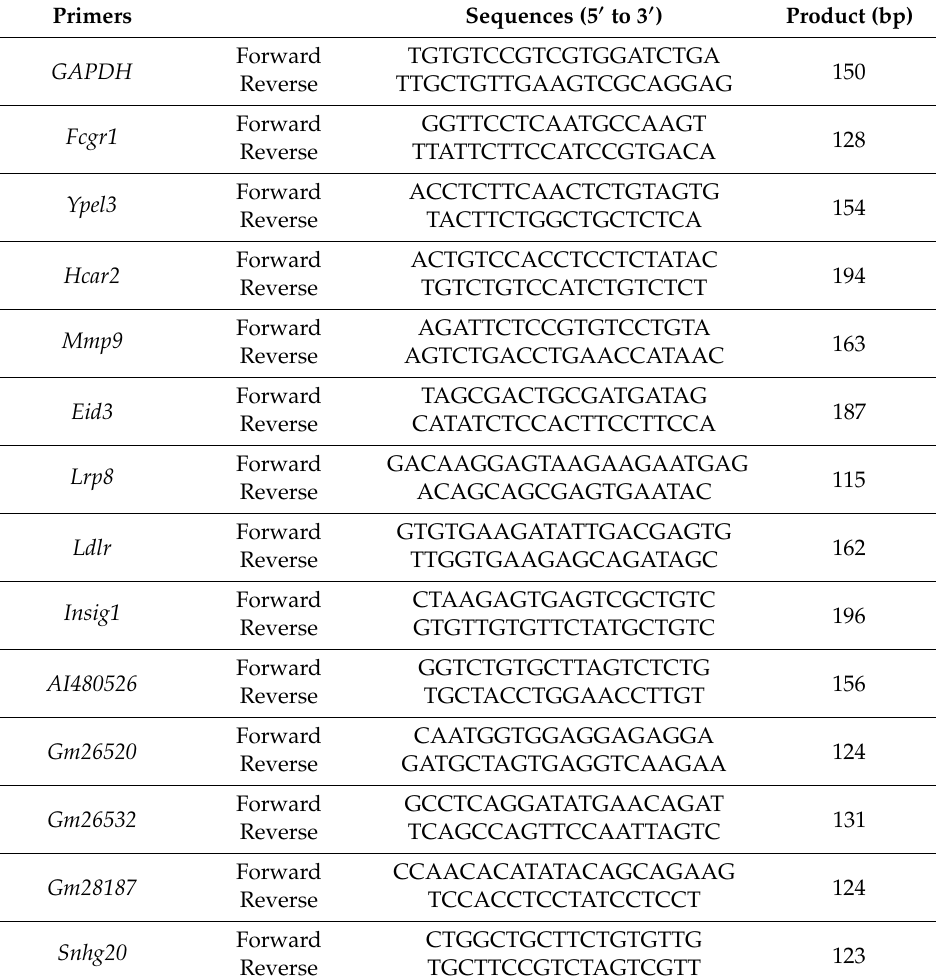
Table 9. Primers used for